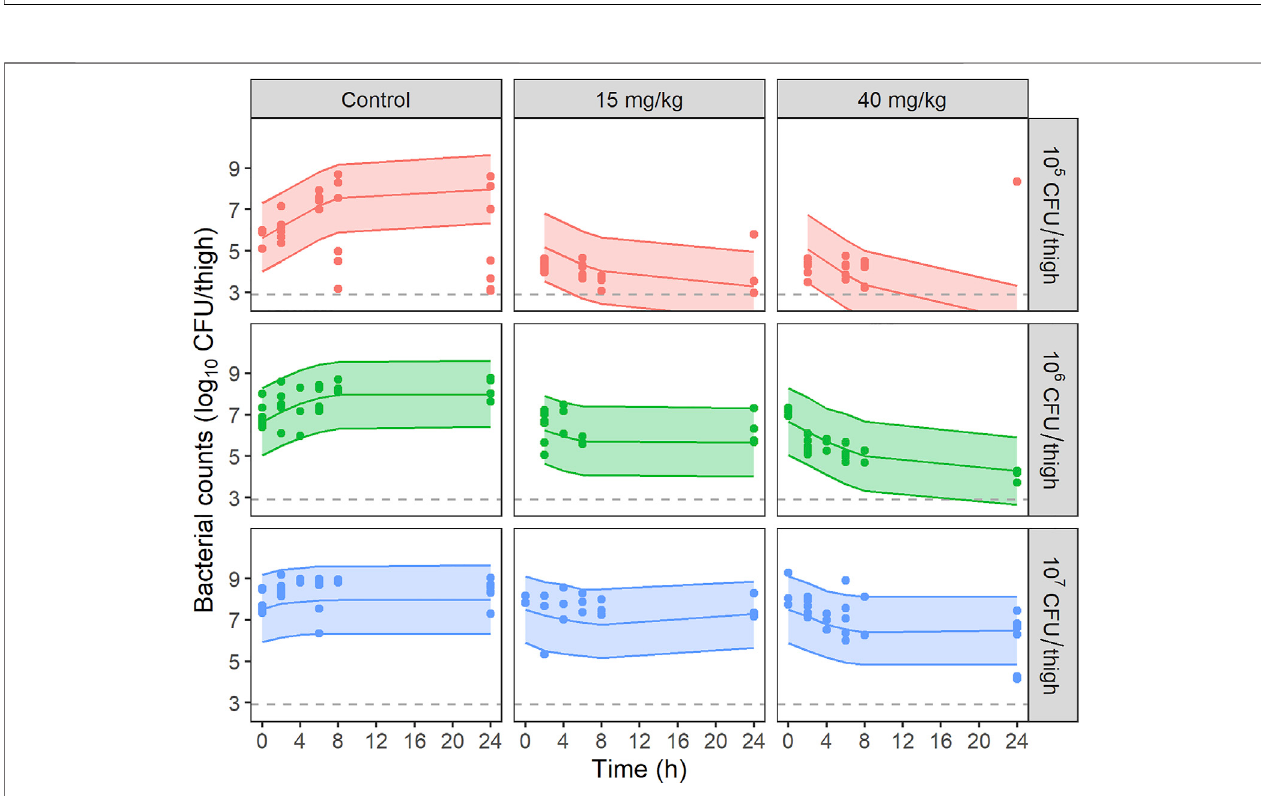
FIGURE3| VPCs ofthe fi nalPKPD model forbacterial counts, strati fi edby doseofPMB and starting inoculum. Circlesrepresentexperimentaldata,solid lines the median of simulated data and, colored areas depict the 80% prediction intervals for 1,000 simulated pro fi les. Dashed lines correspond to the limit of quanti fi cation (2.9 log10